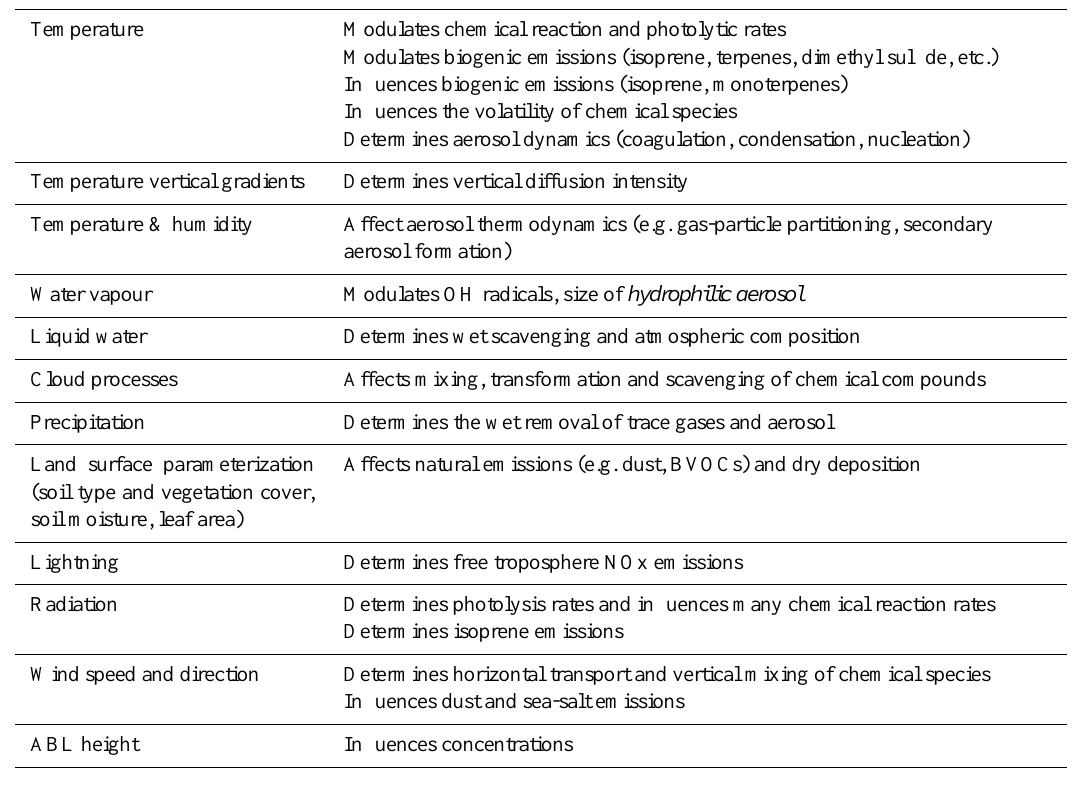
Table 1. Meteorology’s impacts on chemistry.